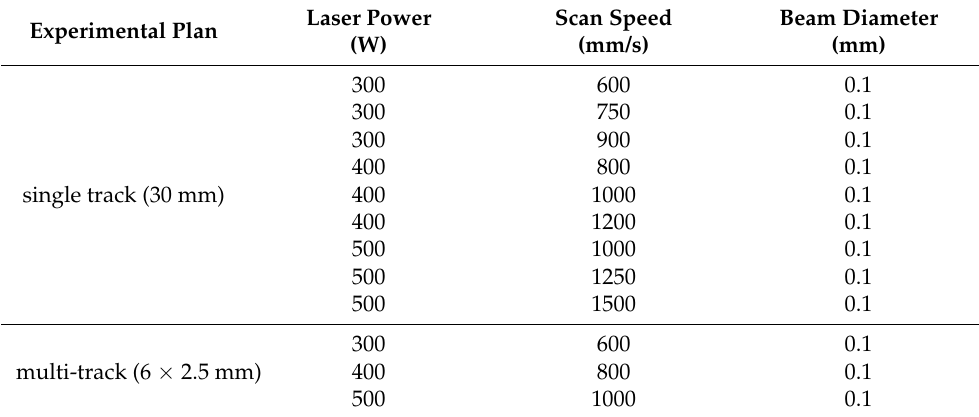
Table 1. Laser parameters used in this study.